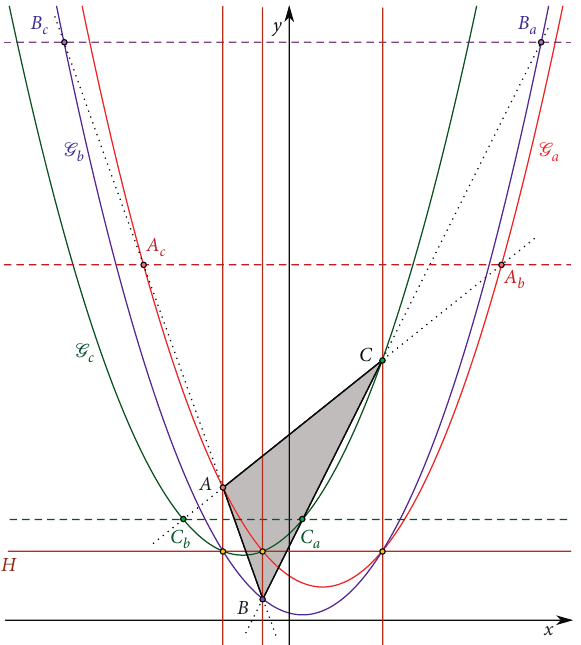
Figure 1: Gob’s circles G